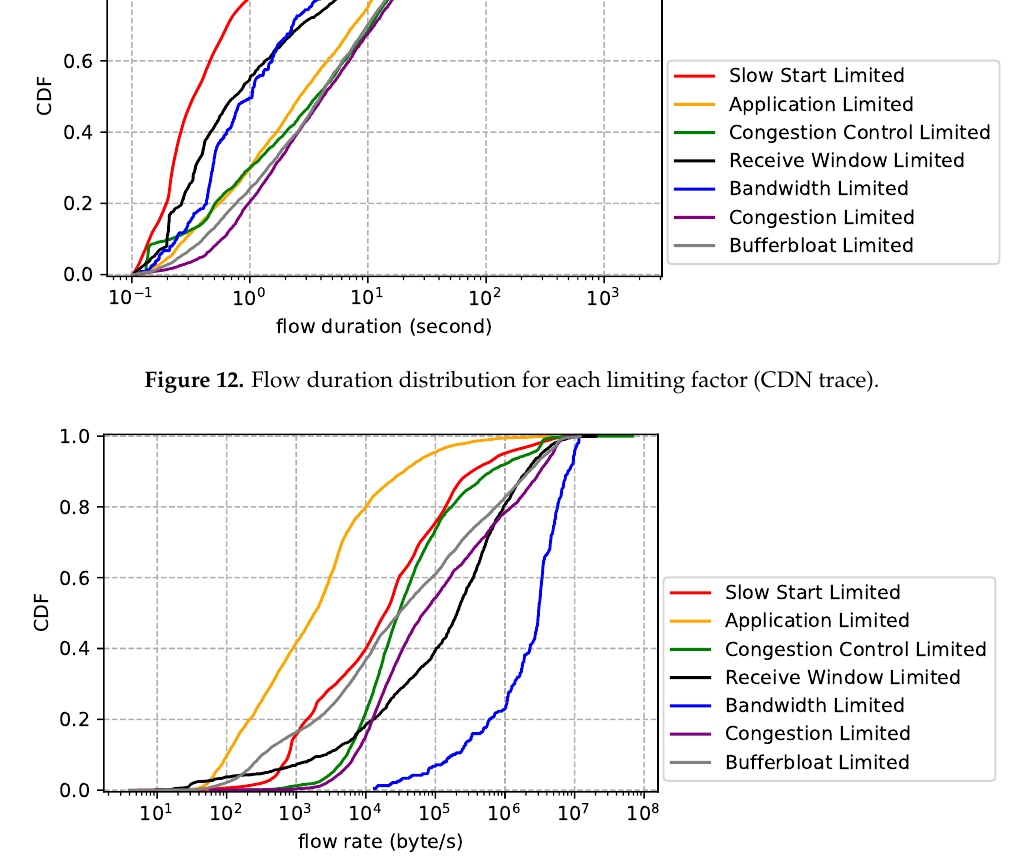
Figure 13. Flow rate distribution for each limiting factor (CDN